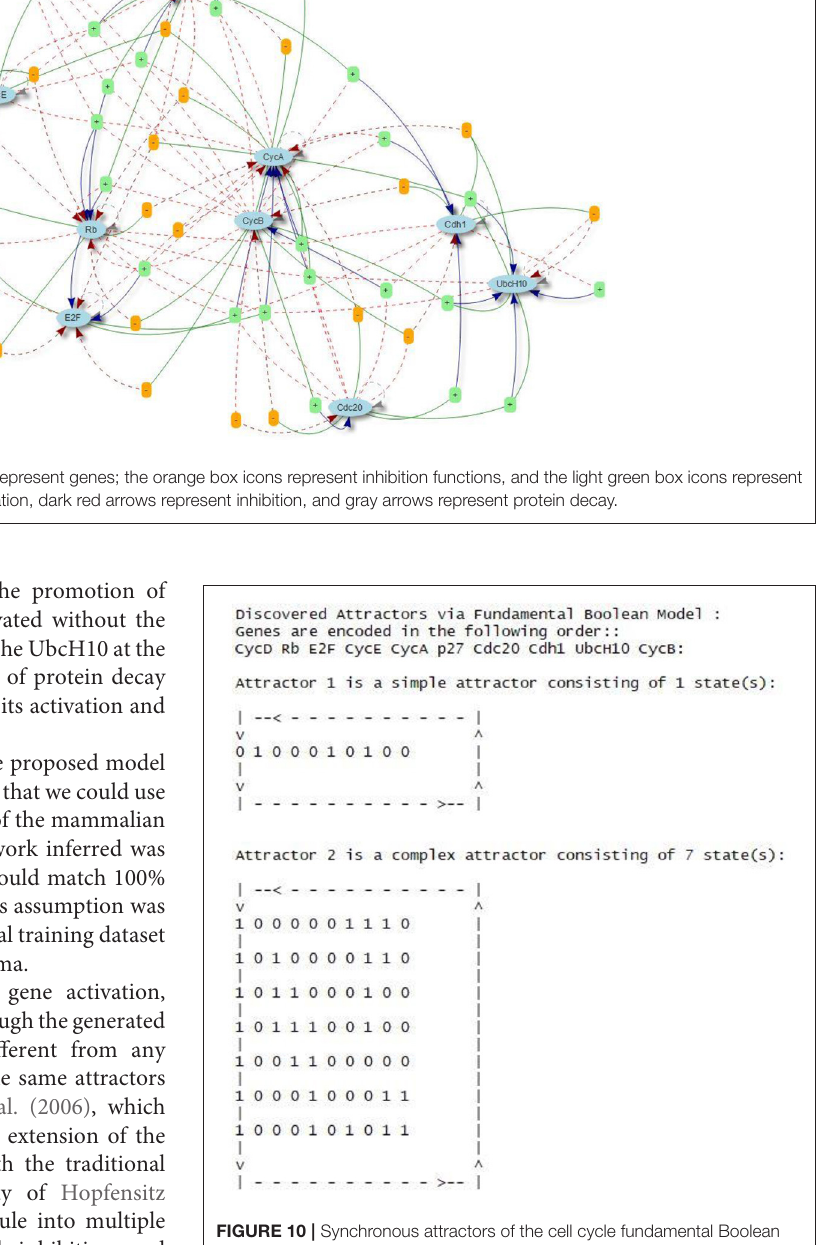
links: activation, inhibition and protein decay (as shown